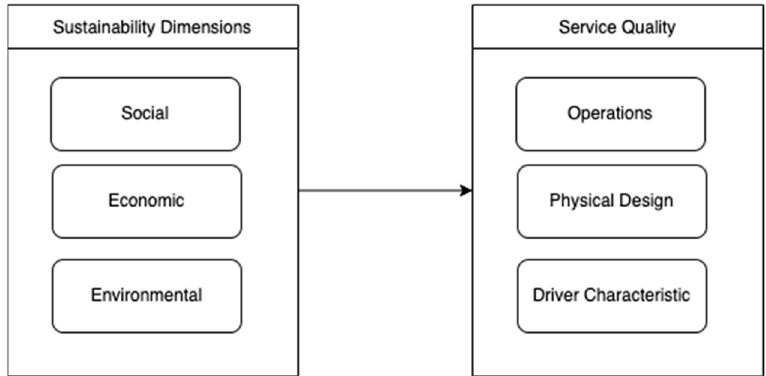
Figure 1. The conceptual framework.